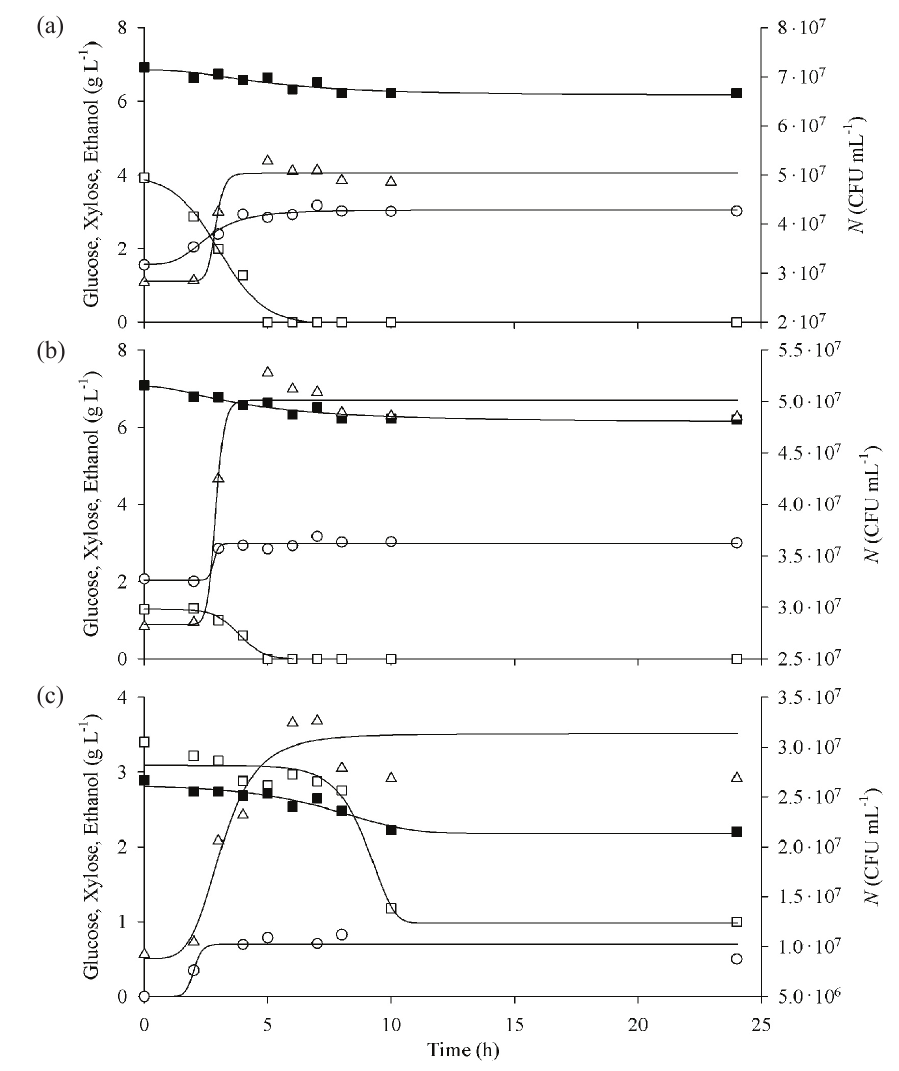
PO (a); wheat 3 4 PO (c) in shake 3 4